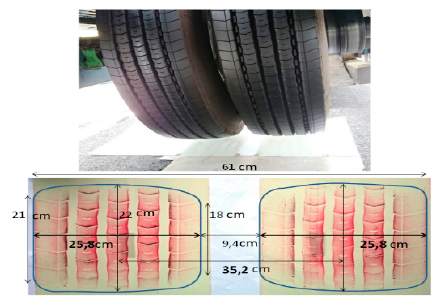
Figure 12. Dual wheel loading dimensions.